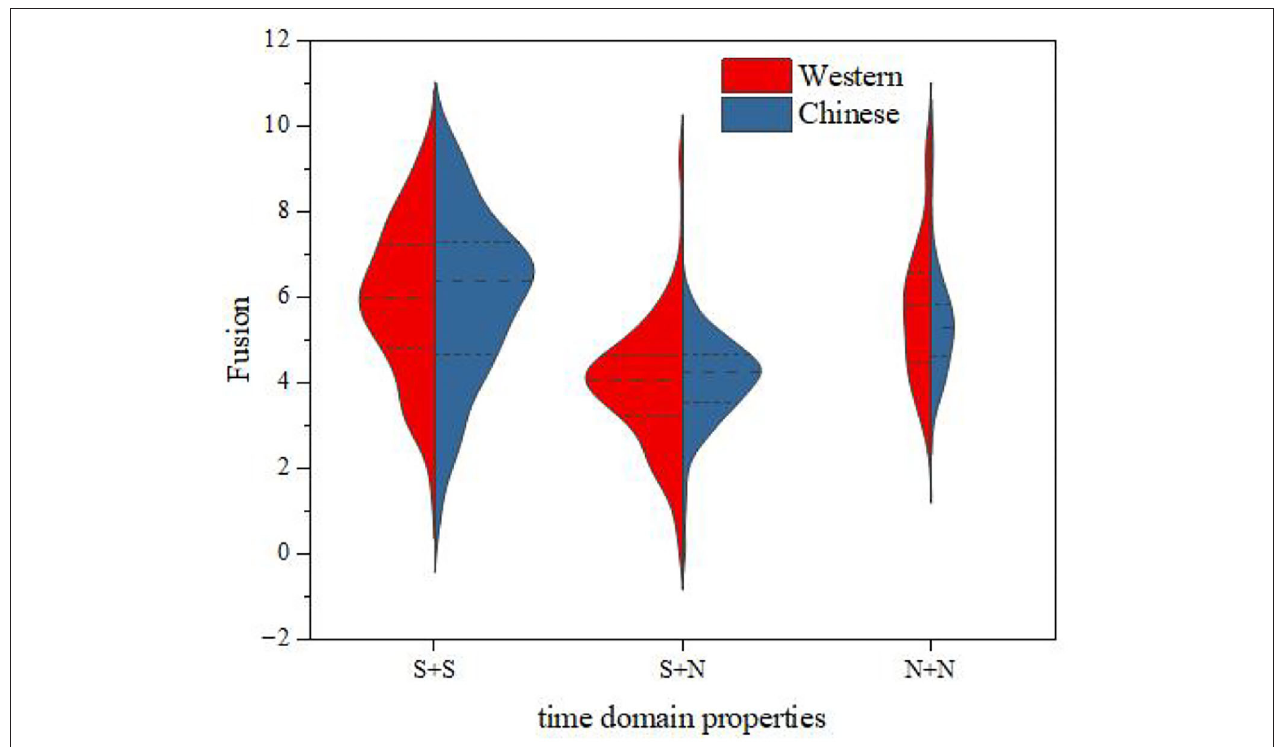
FIGURE 9 | Fusion comparisons between Western and Chinese